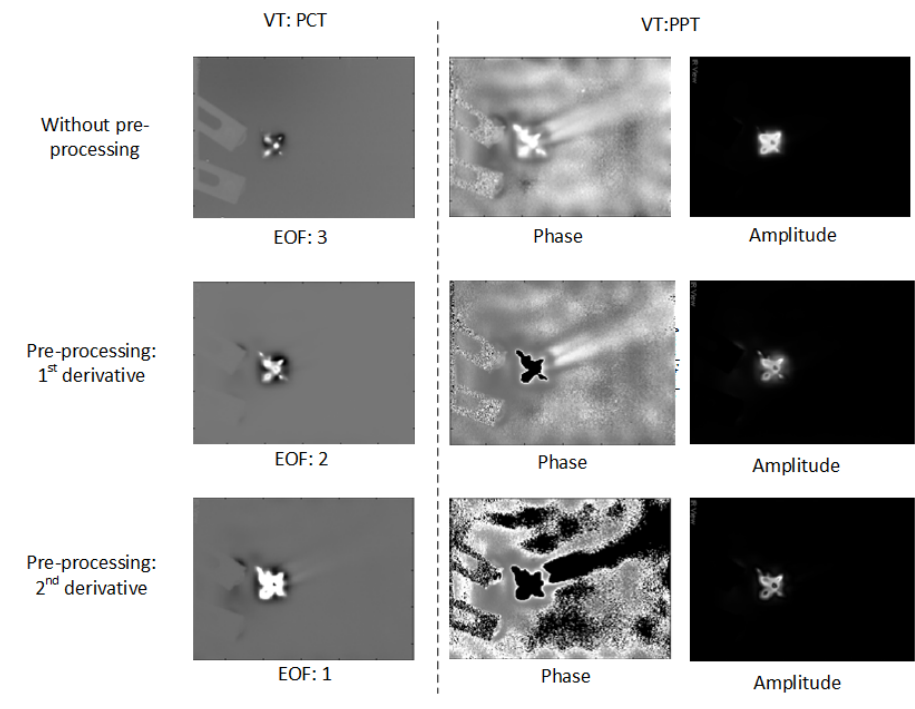
Figure 9. VT results for CFRP 01.